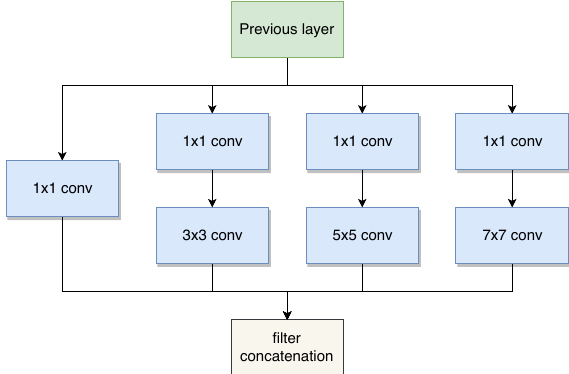
Figure 6. Diagram of the inception module. The number of filters used for each layer is given in Table